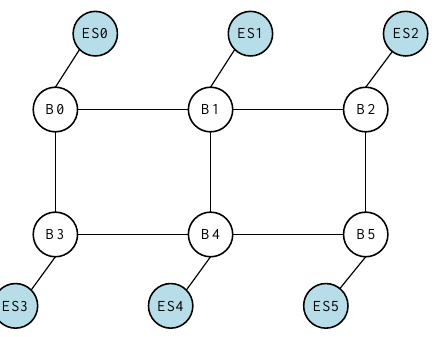
Figure 8. Topology 1, which is a small 2D-mesh topology used in our cases.